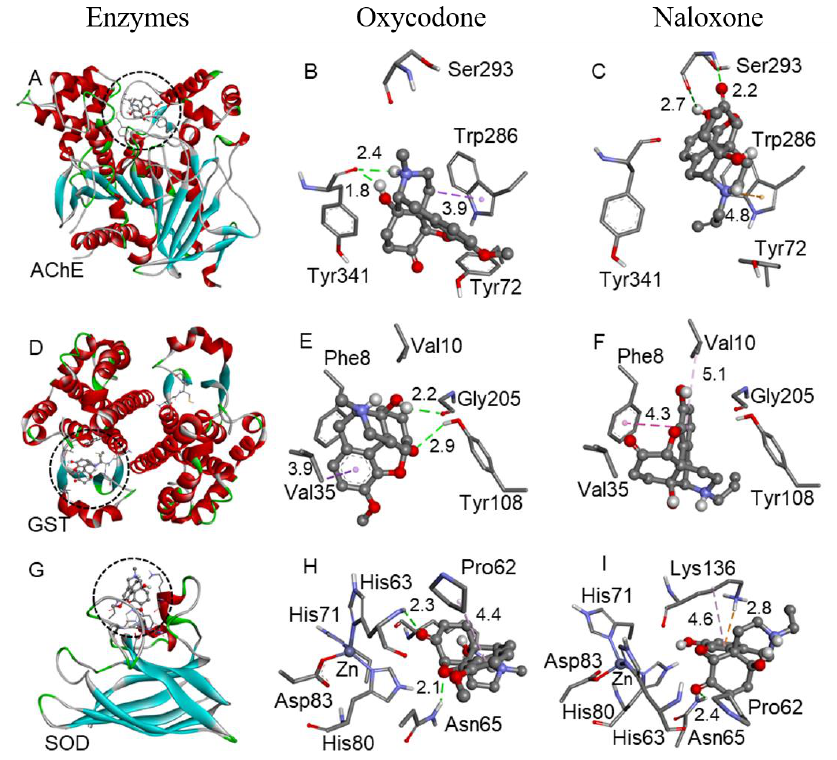
Figure 5. Binding poses of naloxone and oxycodone with the AChE ( A – C ), GST ( D – F ), and SOD ( G – I ) enzymes. Oxycodone ( B , E , H ) and naloxone ( C , F , I ) are represented by the ball-and-stick model. Only the main residues involved in the interactions are shown in the stick model. The interaction distances are in Å , with the H-bonds (green), electrostatic (orange), and hydrophobic interactions (purple) represented by dotted lines.